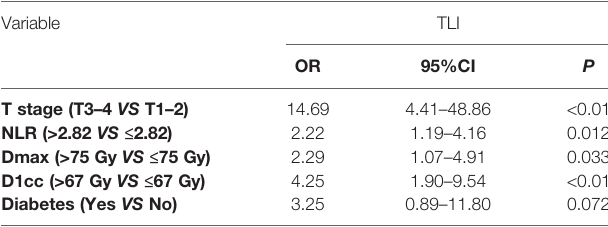
TABLE 4 | Multivariate logistic regression analysis of TLI in primary cohort. Variable TLI OR